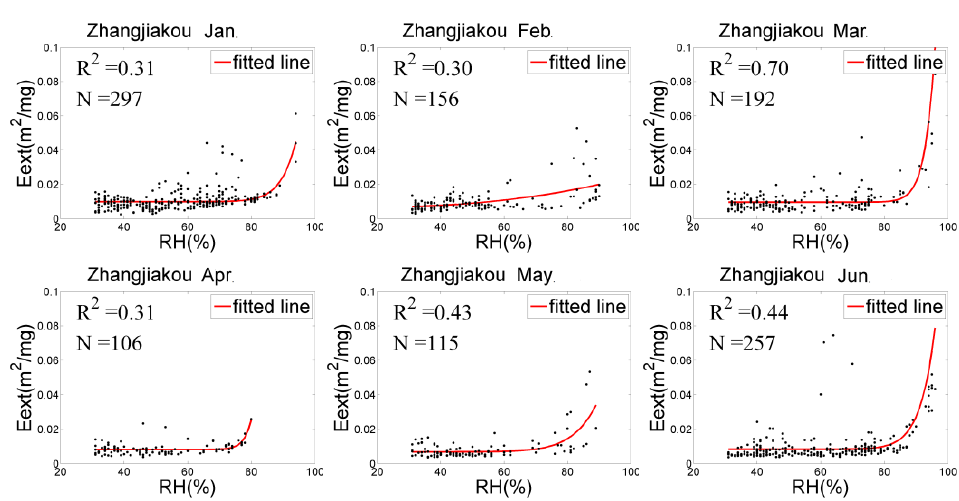
Figure 5. E ext ( RH ) fitting at Zhangjiakou-Huaian.